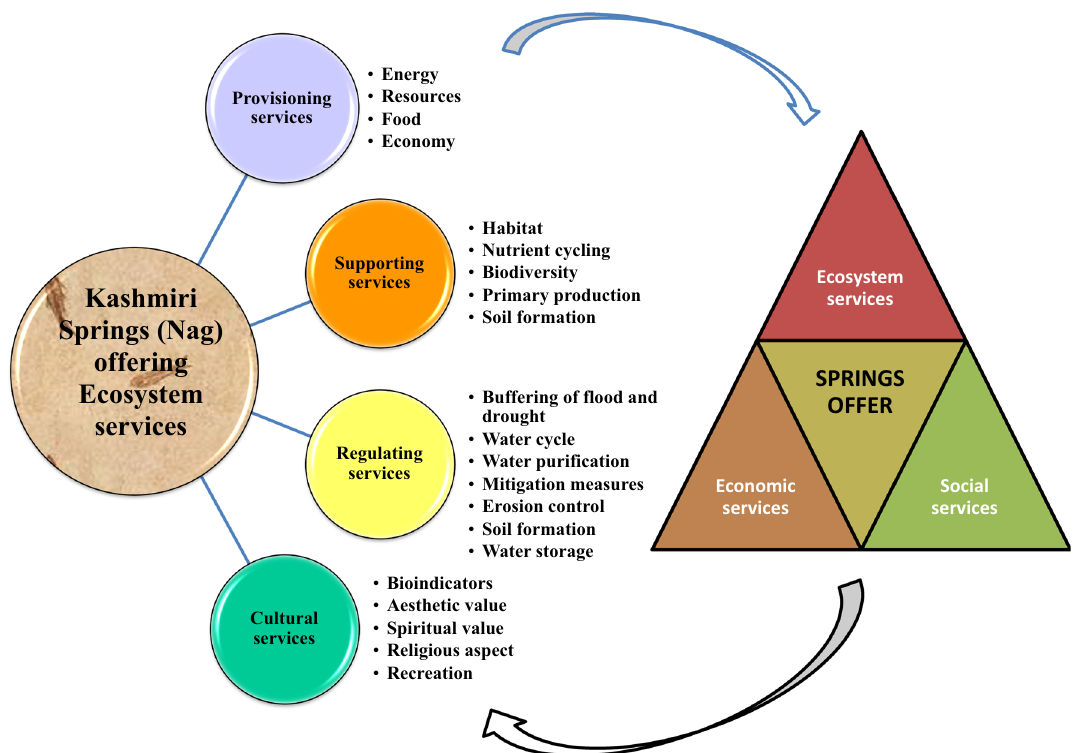
Fig. 9 Listing of various ecosystem services offered by Kashmir Himalayan